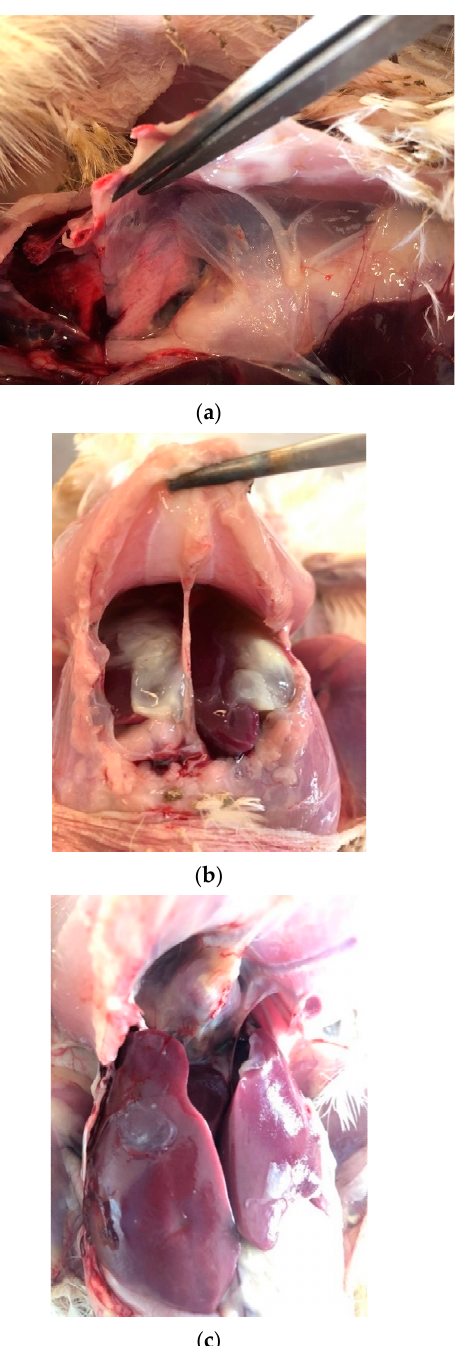
Figure 1. Riemerella anatipestifer : ( a ) Airsacculitis of the thoracic air sacs in broiler chicken filled with organized yellow casts; ( b ) Serositis in broiler chicken; ( c ) Pericarditis & perihepatitis in broiler chicken; ( d ) Transparent, glistening and non-hemolytic colonies on Sheep Blood Agar (CBS); ( e ) Gram-stained smear from culture showing the typical pleomorphic appearance.